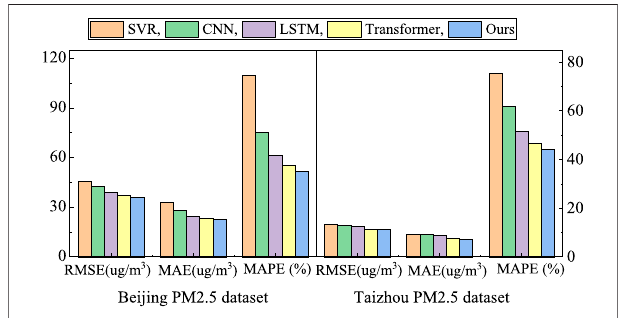
FIGURE 7 | Comparisons of different methods for multi-step prediction results for the next 6 h.